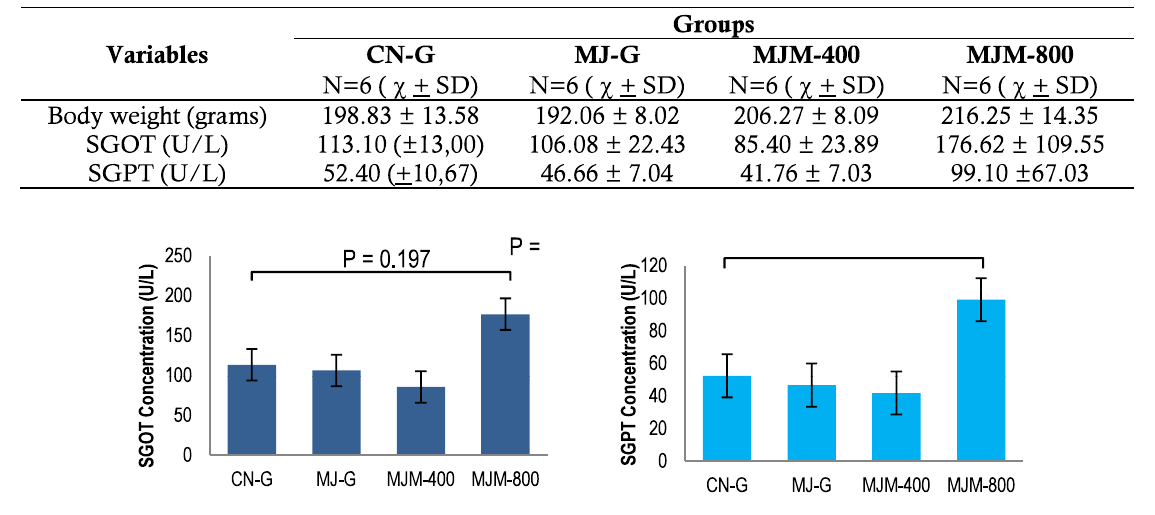
Table 1. Mean rat body weight, SGOT and SGPT